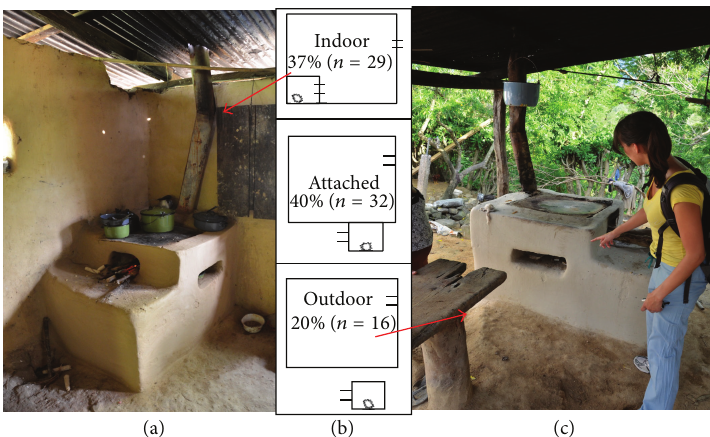
Figure 1: Diagram of stove locations. (b) Schematic diagram of stove locations (see Appendix A). Thirty-seven percent of individuals identified their stove in an indoor location, 40% identified their stove in an attached location (w.r.t. their main living quarters), and 20% identified their stove location in an outdoor location. (c) Typical outdoor stove. (a) Typical indoor stove.